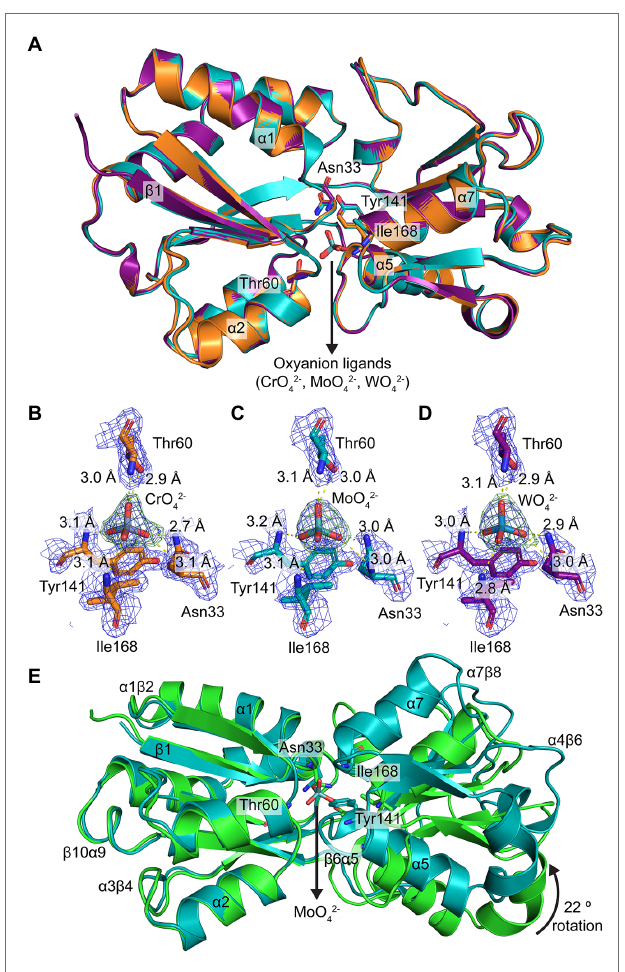
FIGURE 3 | Structural characterization of metal-bound P. aeruginosa ModA. (A) Structural superposition of the crystal structures of metal [chromate (orange), molybdate (teal), tungstate (purple)]-bound ModA in cartoon representation. Some of the secondary structures are assigned and labelled. The coordinating residues and metal oxyanion ligands are shown in stick representation and labelled. The nitrogen and oxygen atoms are colored blue and red, respectively. (B–D) Hexacoordinate hydrogen bonding of (B) chromate, (C) molybdate, and (D) tungstate at the binding site. The hydrogen bonds are shown as yellow dotted lines and labelled with their respective bond lengths. The metals and residues are shown in stick representation and labelled. The 2mF o -DF c electron density maps of the coordinating residues and metals are colored in dark blue and contoured at 1.5 σ , within a 2.0 Å radius around each residue. The polder (OMIT) electron density maps of the metals are colored in dark green and contoured at 4.0 σ , within a 2.0 Å radius around the ligand. (E) Structural superposition of the crystal structures of metal-free (green) and molybdate-bound (teal) ModA in cartoon representation. Some of the secondary structures and loops are assigned and labelled. The coordinating residues and metal are shown in stick representation and labelled. The nitrogen and oxygen atoms are colored blue and red,